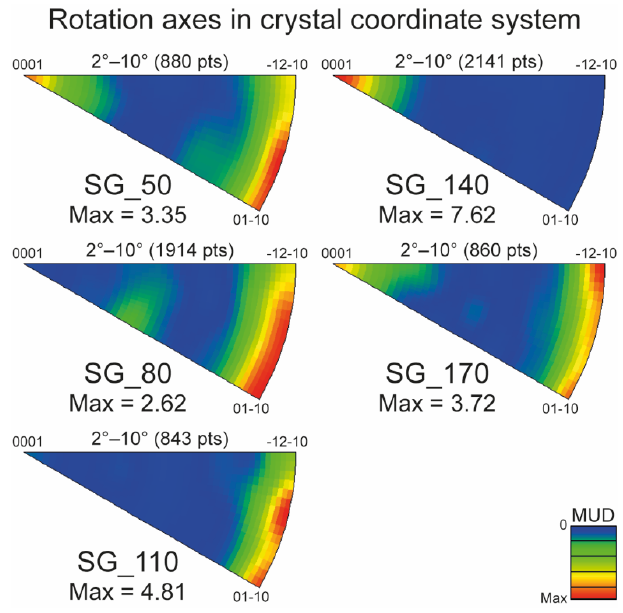
Figure 8. Rotation axes of the analyzed samples computed using the program Channel 5. The term “Max” denotes the maximum of mean uniform density. These are upper hemisphere plots, contoured with a half width of 10°.